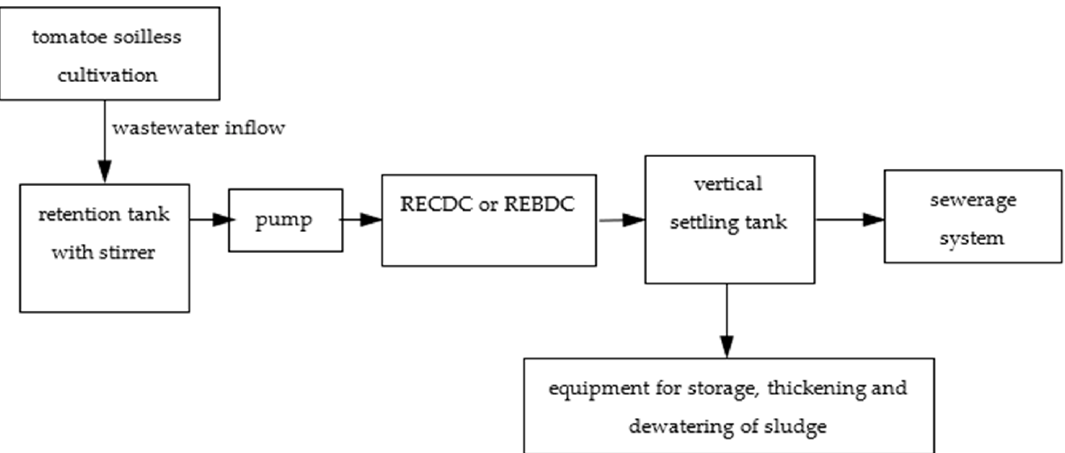
Figure 6. Scheme of a technological system with electrochemical or electrobiological rotating disc contactors for treating wastewater discharged to sewage systems .